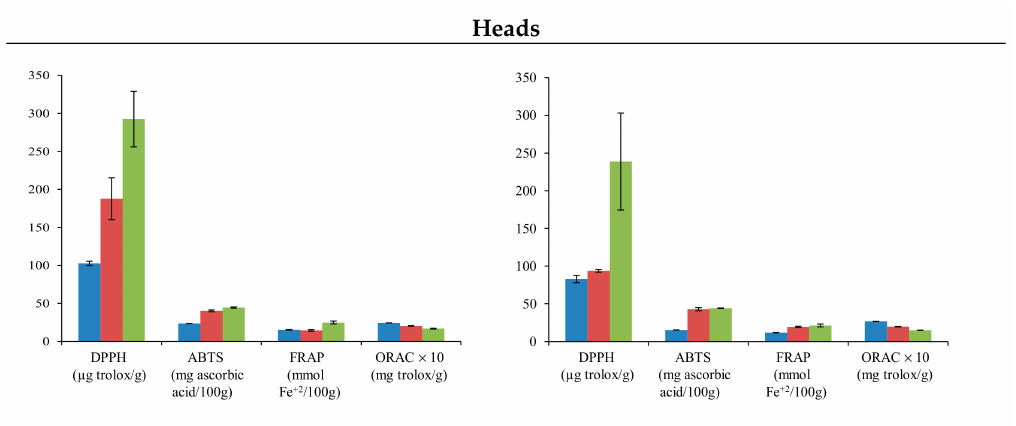
Figure 2. Mean values ± SEM. Antioxidant capacities in residues (bones, gills, and heads) of sea bream and sea bass, using methanol (blue), water (red), and water assisted by PEF (green) extractions.